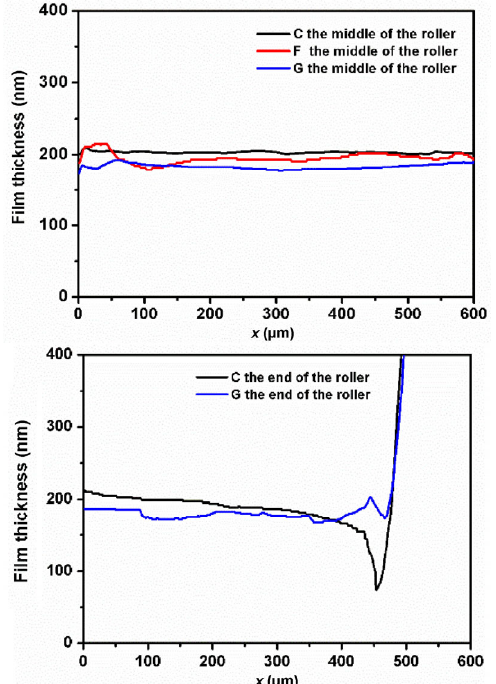
Fig. 7 Film thickness along axial direction with different thickener types ( u = 15 mm/s, p max =0.58 GPa, straight line profile).